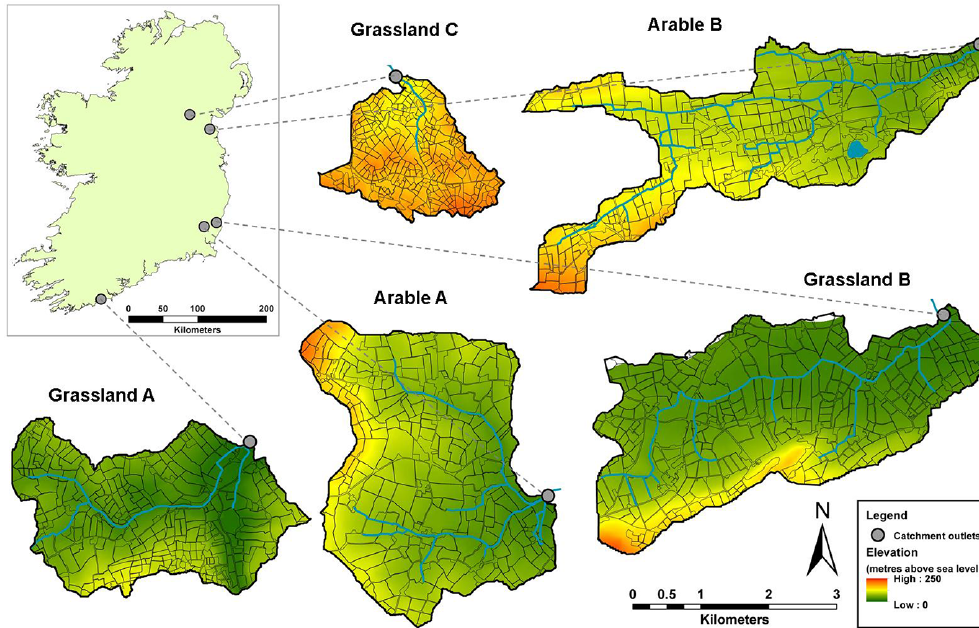
Figure 1. Map of catchment monitoring locations and study catchments with topographic and field size